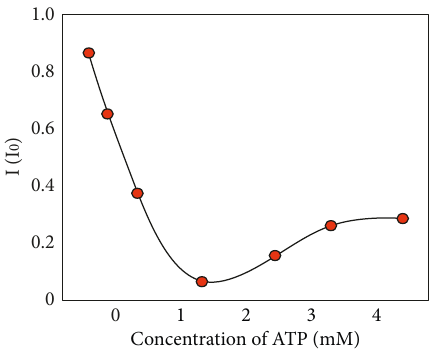
Figure 7: Effect of ATP concentration on the analytical perfor- mance of the